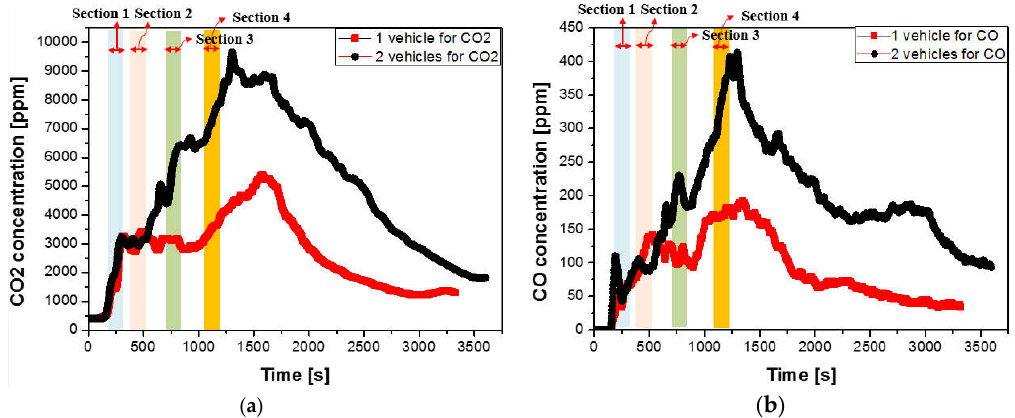
Figure 14. Toxic-substance concentration results: ( a ) Carbon dioxide and ( b ) carbon monoxide. Table 5. Carbon-dioxide concentration at the major change periods, and influences on the body based on value.